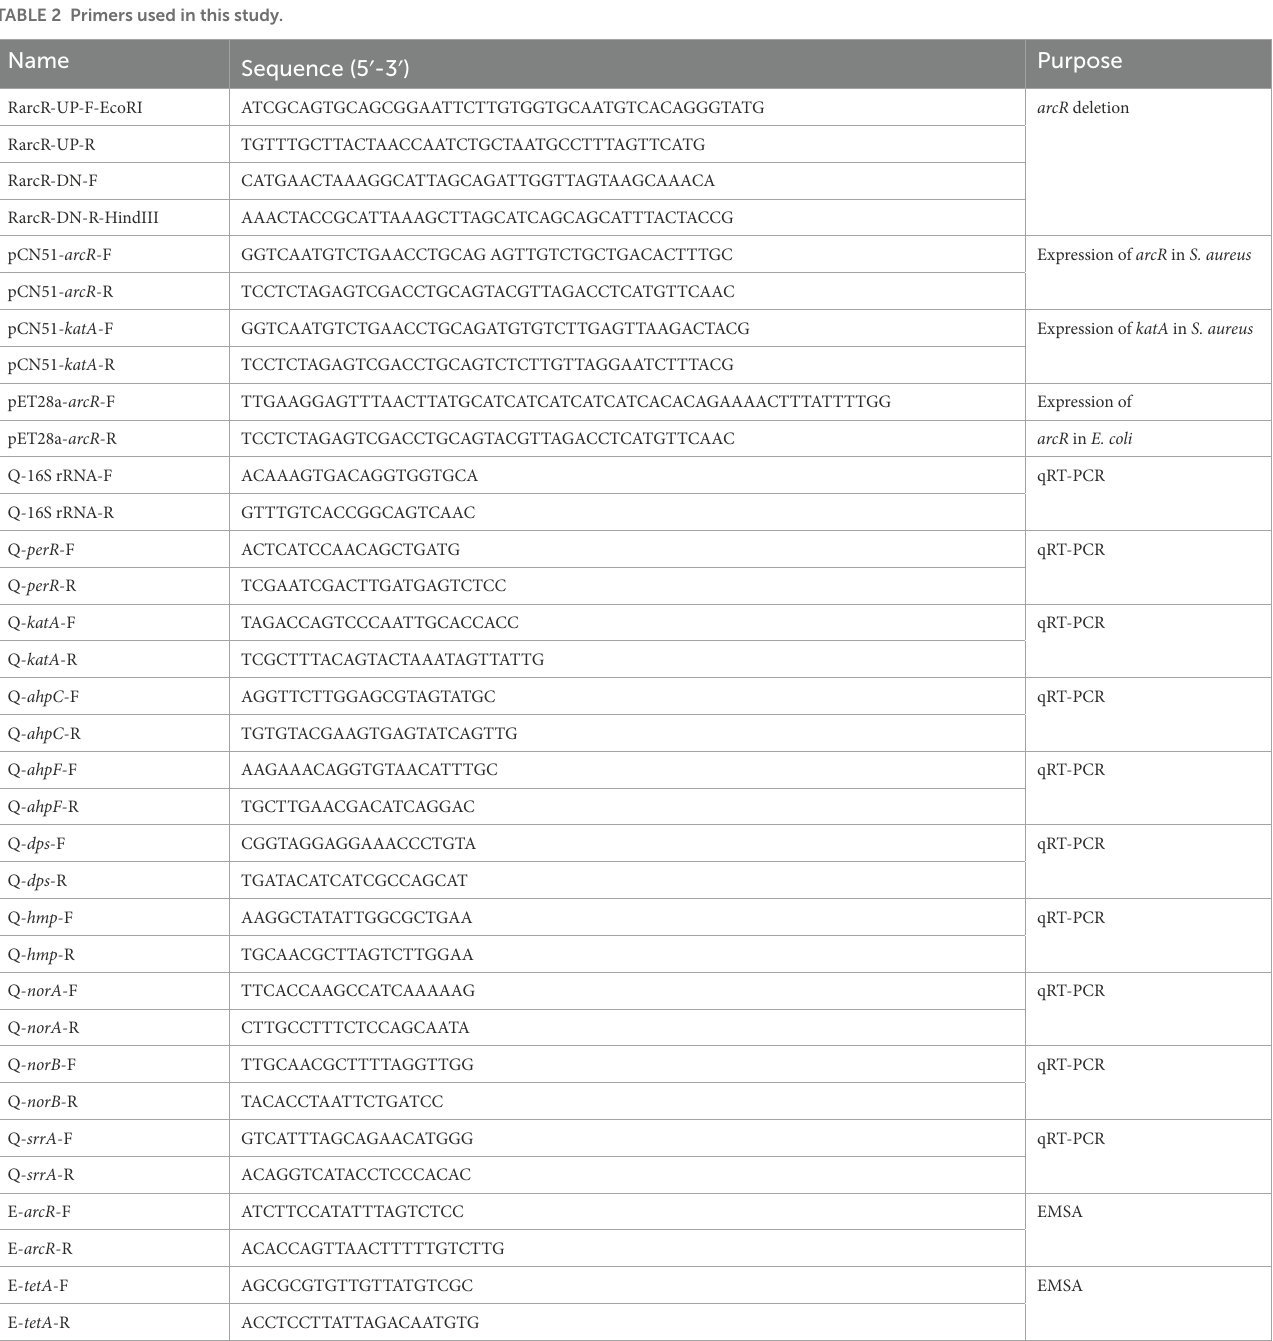
TABLE 2 Primers used in this